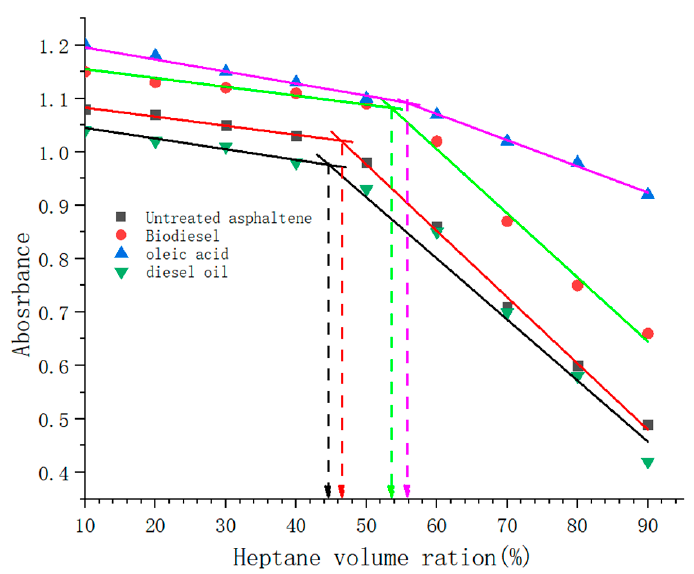
Figure 6. Asphaltene IPP in the existence and absence of an inhibitor (inhibitor concentration is 10% wt./v).